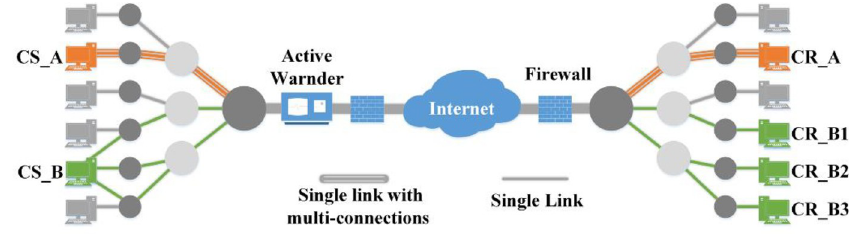
Fig 1. Two structures of a Multi-Link covert